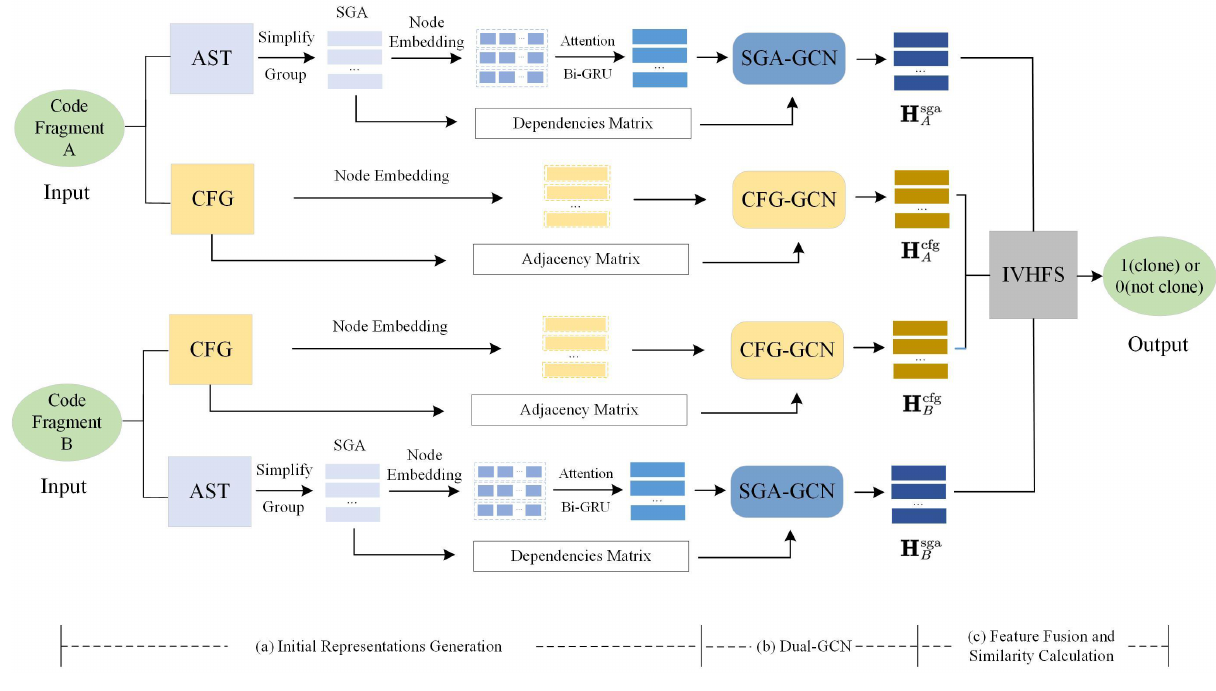
Figure 1. The overall framework of our model based on dual graph convolutional networks and interval-valued hesitant fuzzy set: ( a ) generation of the initial syntax and semantics representations, ( b ) the dual graph convolutional networks capture the relationships between nodes and enhances the features and ( c ) feature fusion and similarity calculation processes of code fragments A and